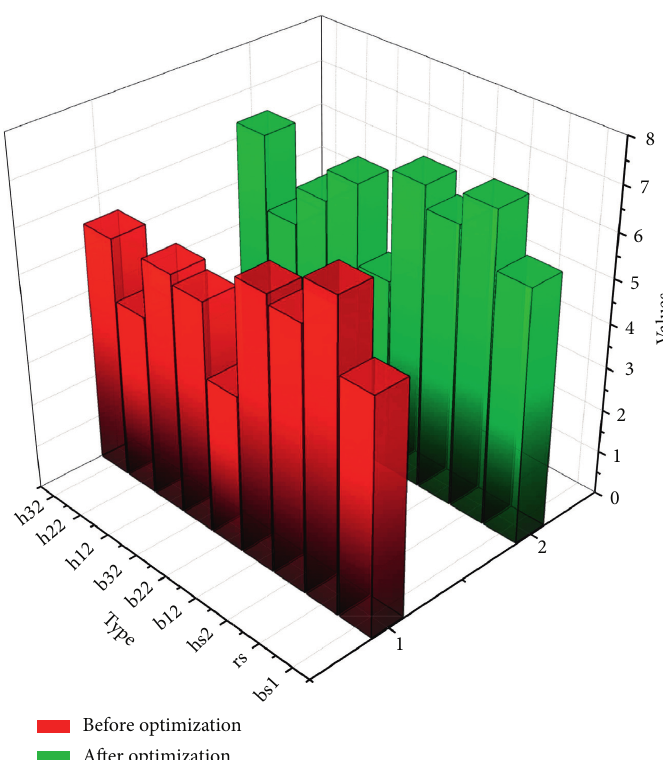
Figure 6: Comparison of each parameter of the optimization variables.